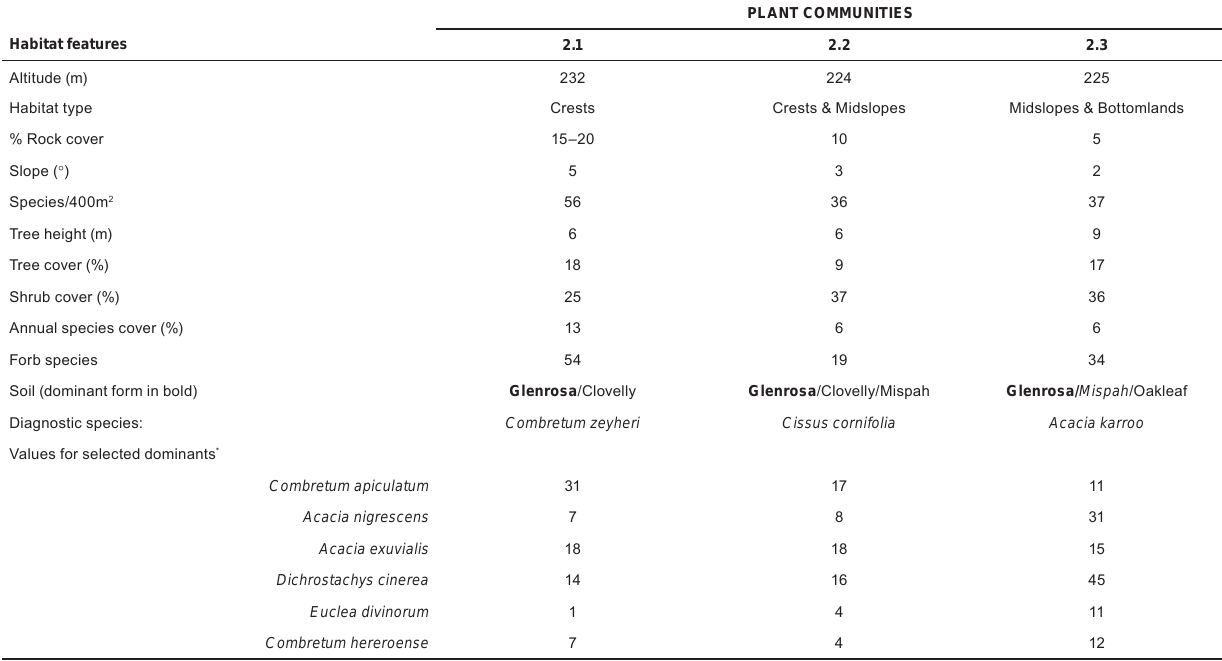
Table 2 exclosure site